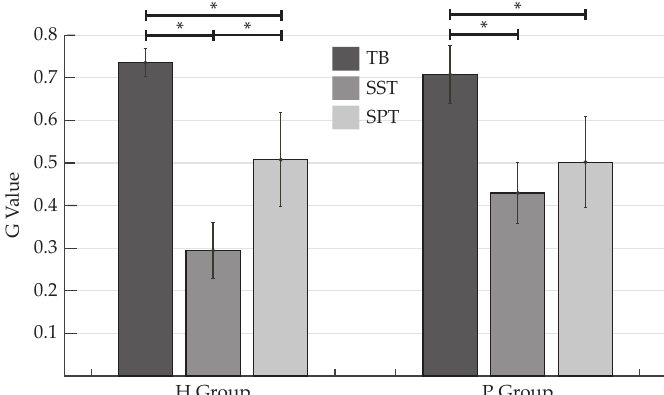
Figure 9. Goodness index (G) for healthy subjects (H) and subjects with mobility impairments (P) for each detection algorithm: threshold-based (TB), and HMM-based algorithm, using subject-specific training (SST) and standardized parameter training (SPT). Asterisks indicate statistically significant differences among classifiers (Bonferroni, p <